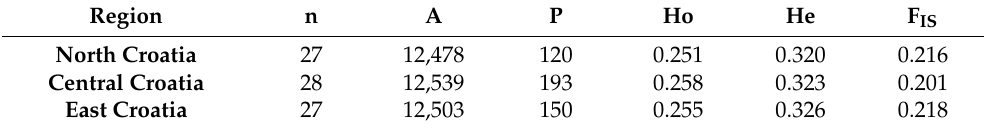
Table 2. Genetic variability of Colorado potato beetles from different geographical regions in